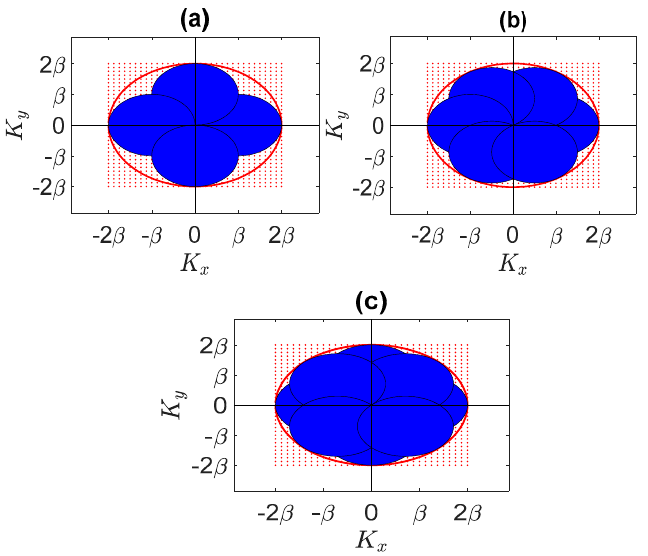
Figure 10. The domain spanned by (a) four incident plane waves, (b) six incident plane waves, and (c) eight incident plane waves in the spectral domain for a planar ID.